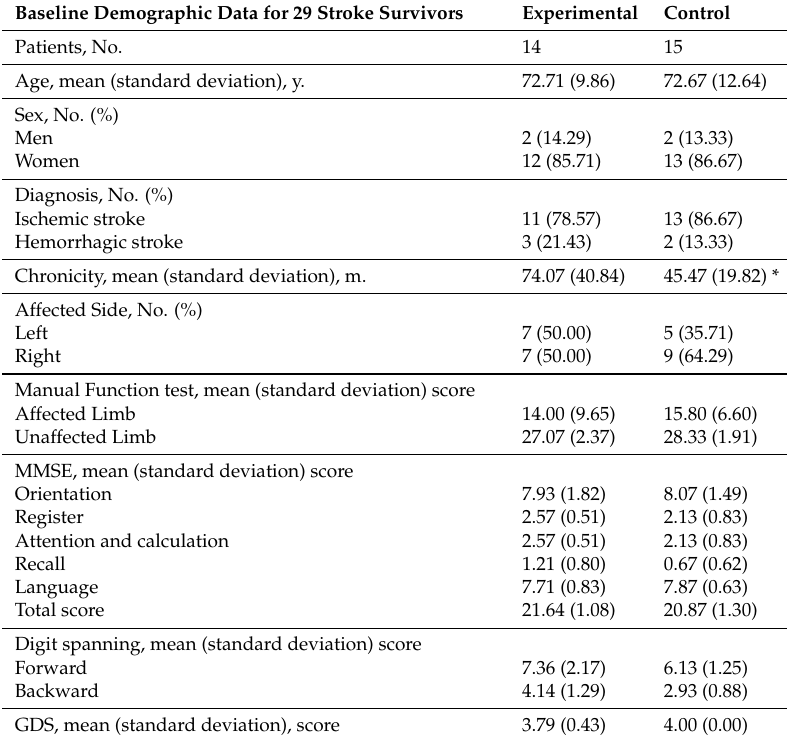
Table 1. Baseline patient demographic information.